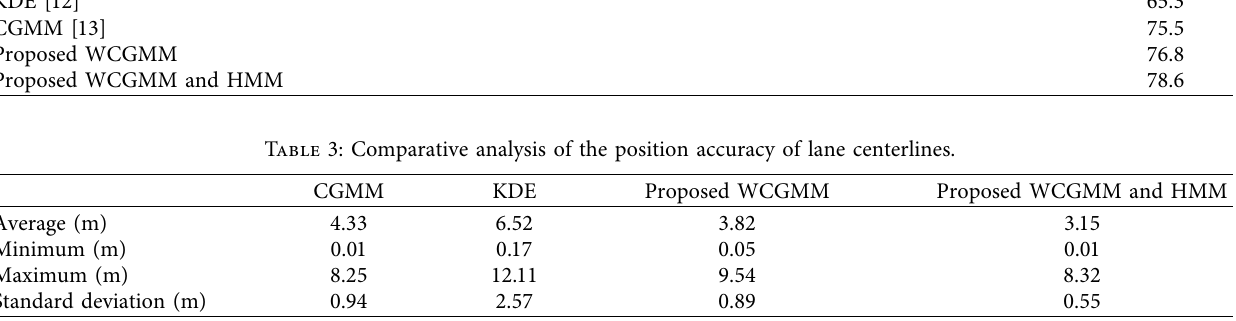
Figure 16: Lane-level road map generation results based on the proposed method within the three selected areas: (a) the extracted lane centerlines and experimental trajectory data; (b) the extracted lane centerlines and reference lane centerlines. Table 2: Accuracy comparison of lane counts extraction Lane counts extraction methods